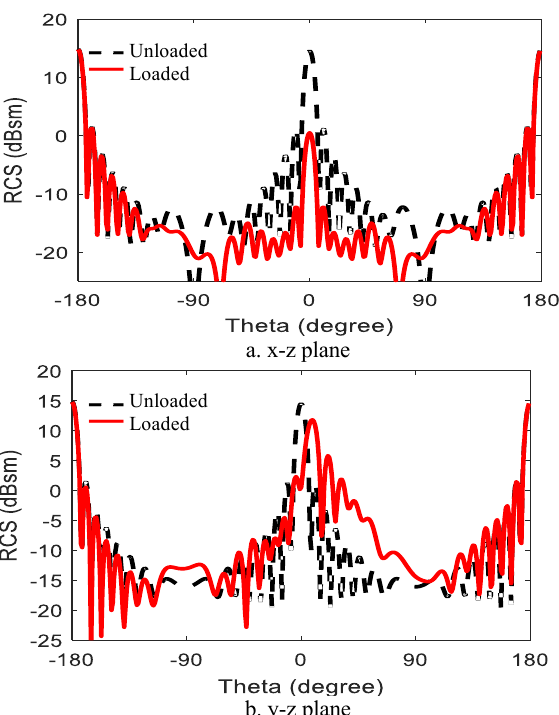
Fig. 4. The angle variation of RCS for one direction tapered holes at α=-0.18 and f =11.75